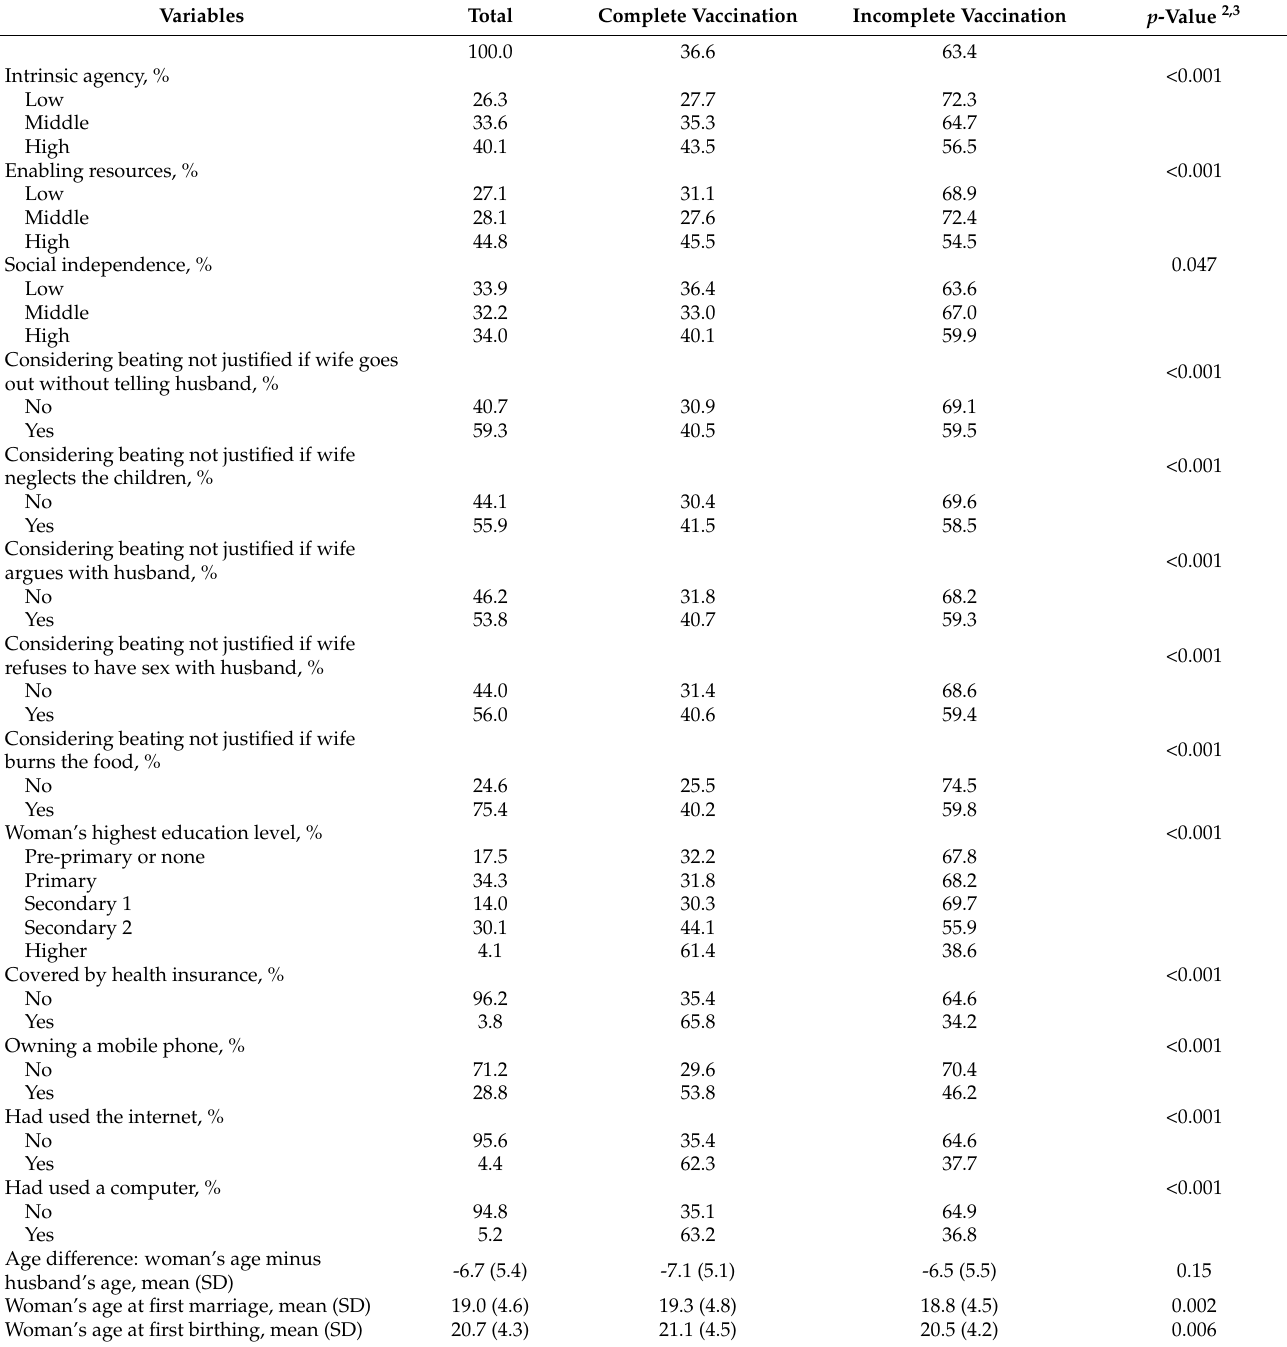
Table 2. Women’s empowerment-related variables in the DRC according to vaccination status of their children aged 12–23 months (N = 3524) 1